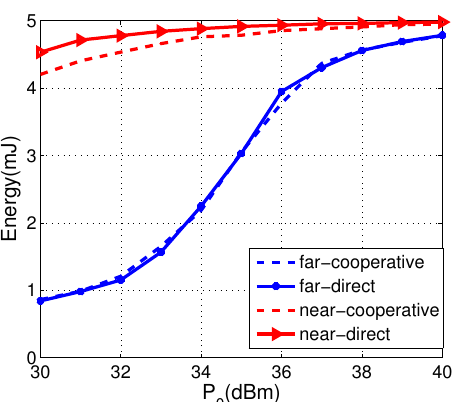
Figure 8. The average residual energy of sensors in the far cluster and near cluster versus the HAP transmit power P 0